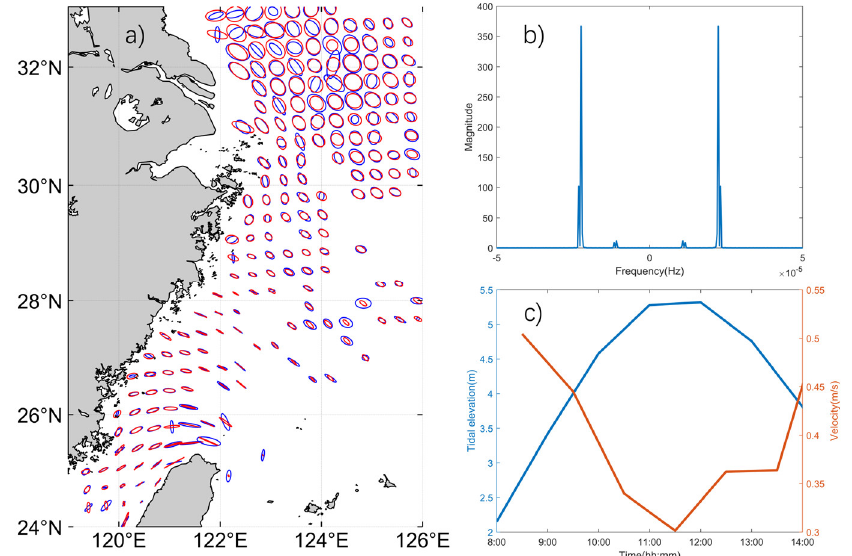
Figure 4. ( a ) M 2 tidal ellipse of MCC − derived current (blue) and the model flow (red), with a red star indicating the location of the local tide gauge station; ( b ) spectrum analysis of one month’s worth of tidal hourly elevation data; and ( c ) tidal elevation variation and spatially averaged flow velocity on 14 February 2017.